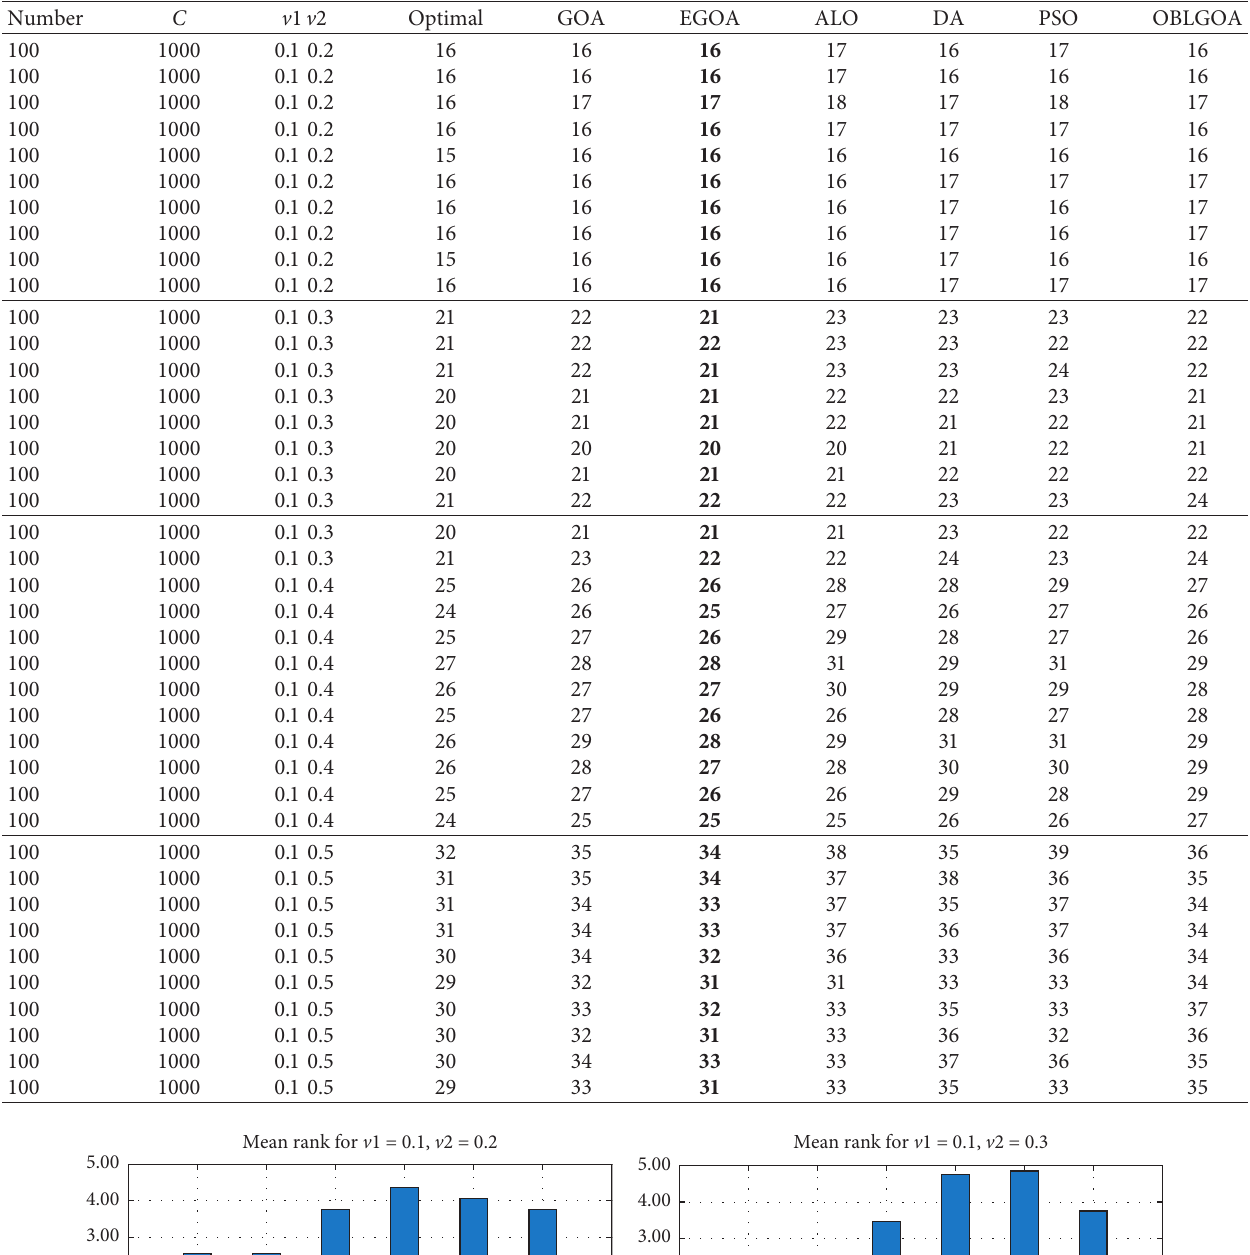
Table 11: Experimental results for the BPP.